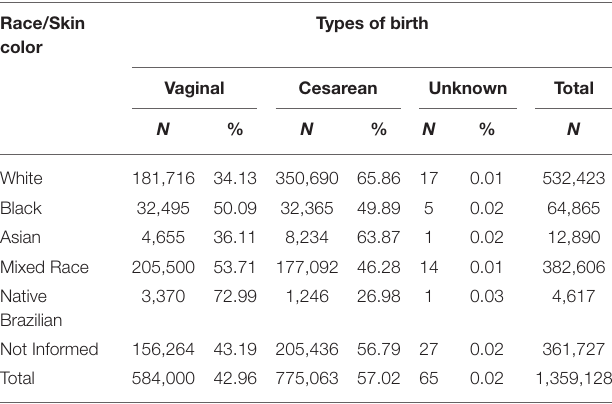
TABLE 3 | Distribution of number and percentage of types of birth according to skin color of women attended within the city of São Paulo, between the years of 2010 and 2016 Source: SINASC/CEInfo/SMS-SP, 2018 (São paulo, 2018).